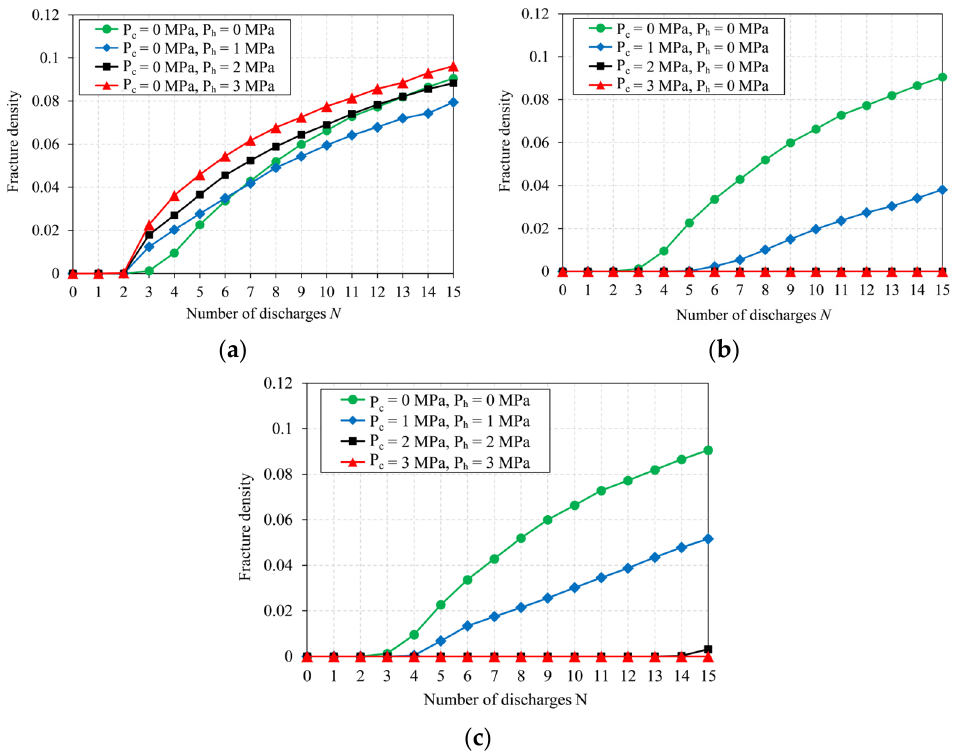
Figure 15. Variation of fracture density under different P c and P h : ( a ) case 1; ( b ) case 2; ( c ) case